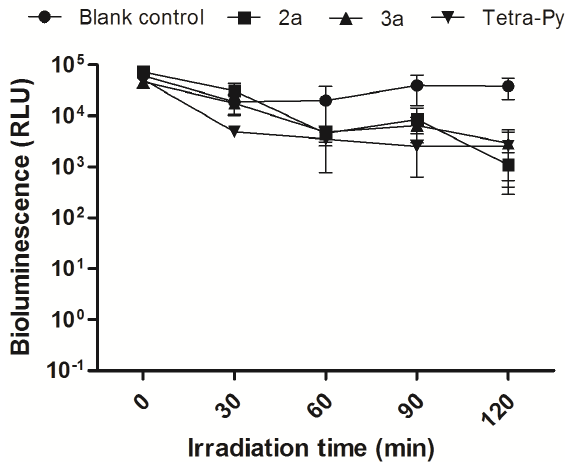
Figure 6 - Bioluminescence monitoring of A. fischeri treated with 10 mM of neutral corroles 2a and 3a and 5,10,15,20-tetra(4- pyridyl)porphyrin (Tetra-Py) after irradiation with white light (400-800 nm) at an irradiance of 100 mW cm -2 during 120 min. Each value represents the mean ± standard deviation of three independent experiments, with two replicates each. Error bars indicate the standard